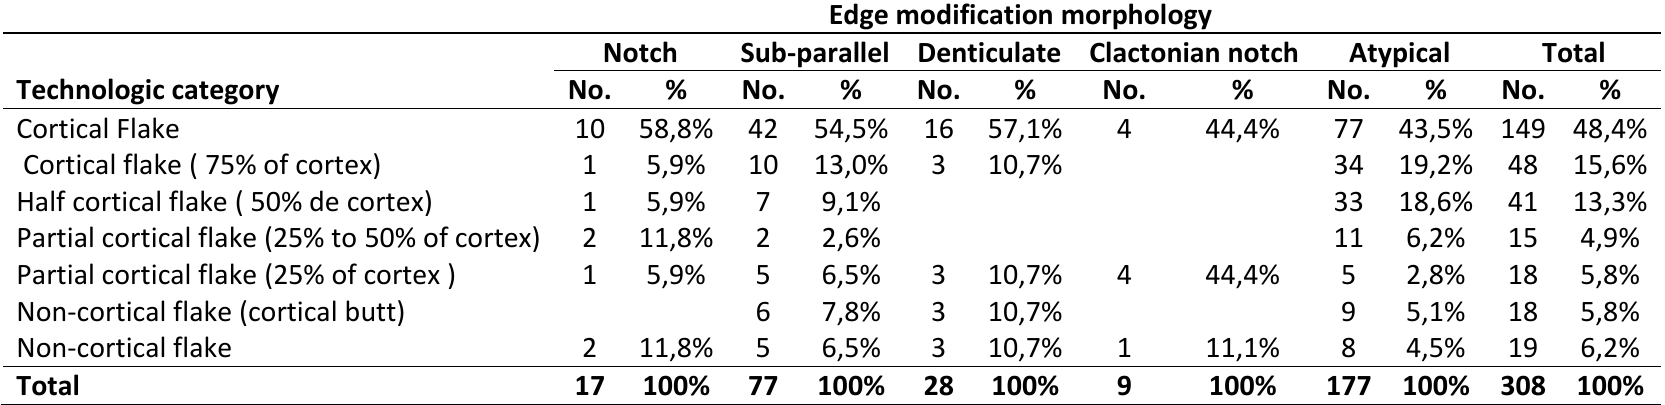
Table 4. Relation between flake technological category and edge modification morphology.